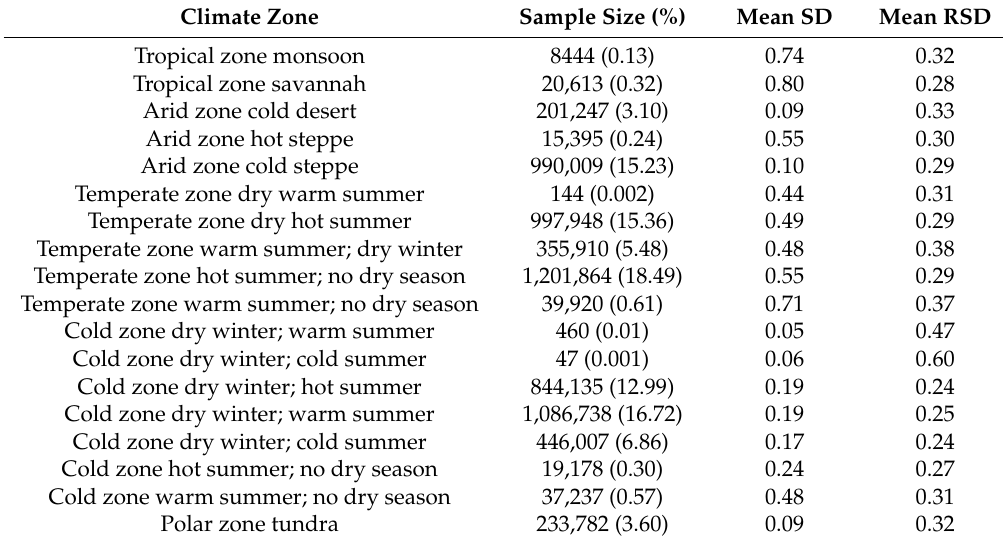
Table 5. Mean SD and RSD for each climate